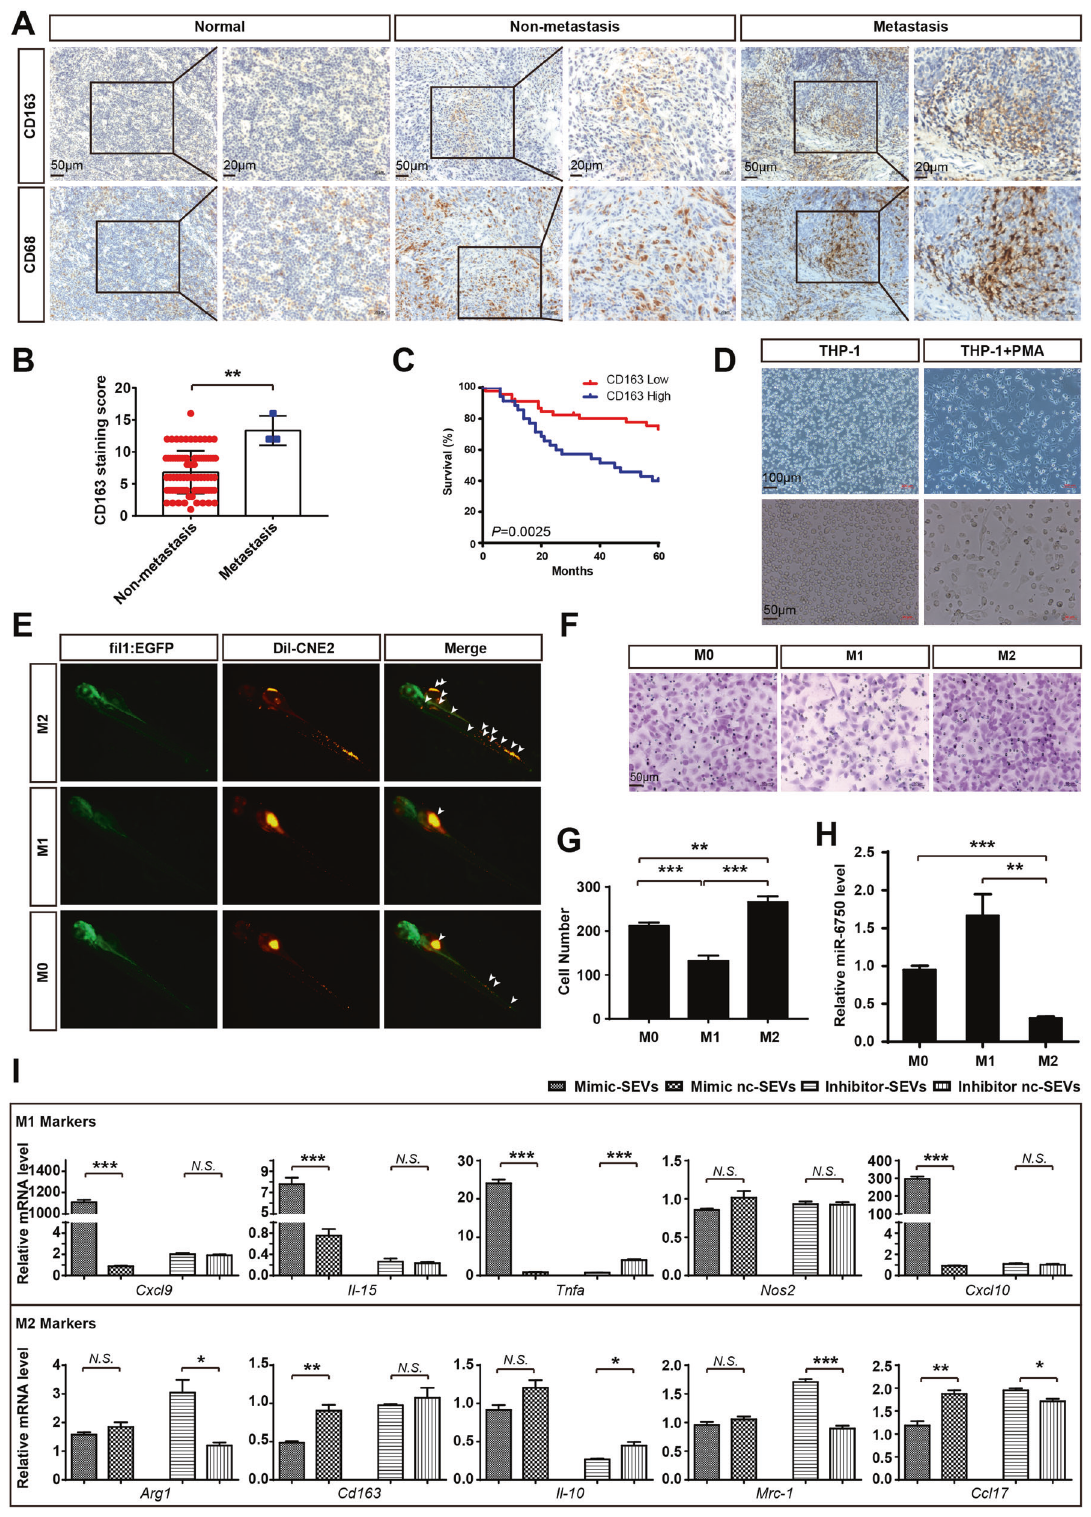
Fig. 3 MiR-6750-SEVs can be shuttled to Macrophage in TME to regulate macrophage phenotype. A Representative images of CD163/ CD68 in tissues collected from graph-depicted groups. B Student ’ s t-test between CD163 expression and NPC metastasis. C Statistical analyses of the association of CD163 level with survival time of the patients. Log-rank test. Staining score of CD163 in NPC tissue was de fi ned as low expression (scores of 0 – 8) or high expression (scores of 9 – 16) by the X-tile Software. D Representative image of macrophages was shown (THP-1 cells were treated with or without PMA). E NPC cell dissemination and metastasis was analyzed by a zebra fi sh model. Arrowheads indicate disseminated tumor foci. F , G Transwell migration assays were performed to measure cell migration. Student ’ s t-test. H miR-6750 levels in Macrophage were measured by qRT-PCR. Student ’ s t-test. I M0 Macrophages treated with various SEVS was used to measure Macrophage phenotype by qRT-PCR assay. Student ’ s t-test. Cell Death Discovery (2023)